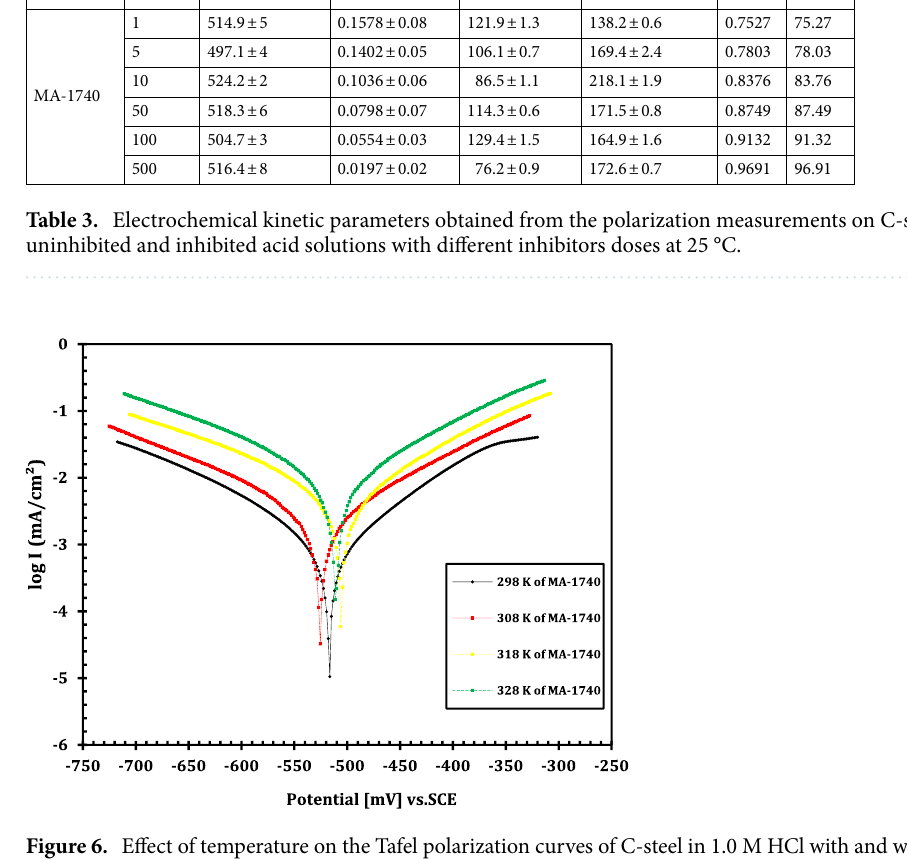
Figure 6. Effect of temperature on the Tafel polarization curves of C-steel in 1.0 M HCl with and without compounds.